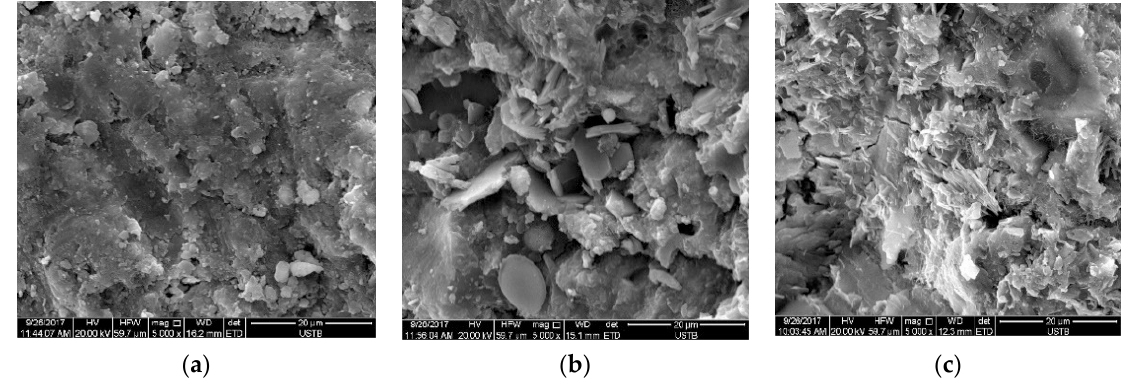
Figure 15. SEM of C30 concrete with different magnesium oxide contents at the age of 120 d. ( a ) C30-0%-120d; ( b ) C30-3%-120d; ( c ) C30-6%-120d.